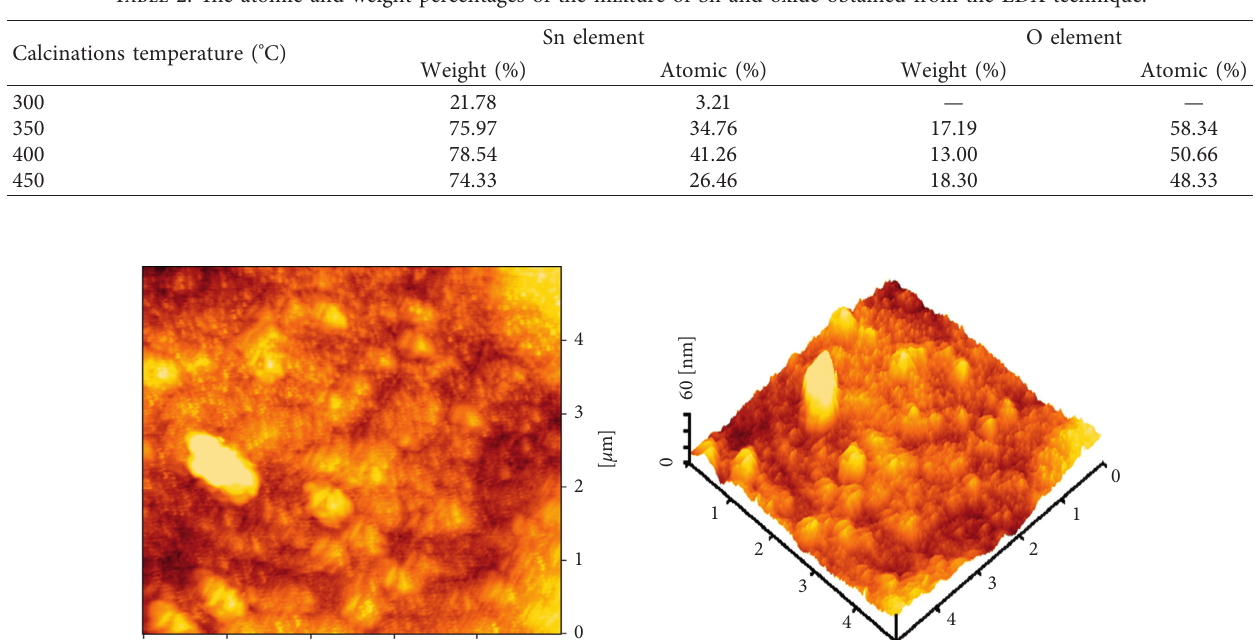
° C (5 × 5 µ m 2 ) and (b) 450 ° C (2.5 × 2.5 µ m 2 ) of calcination 2 films: (a) 350